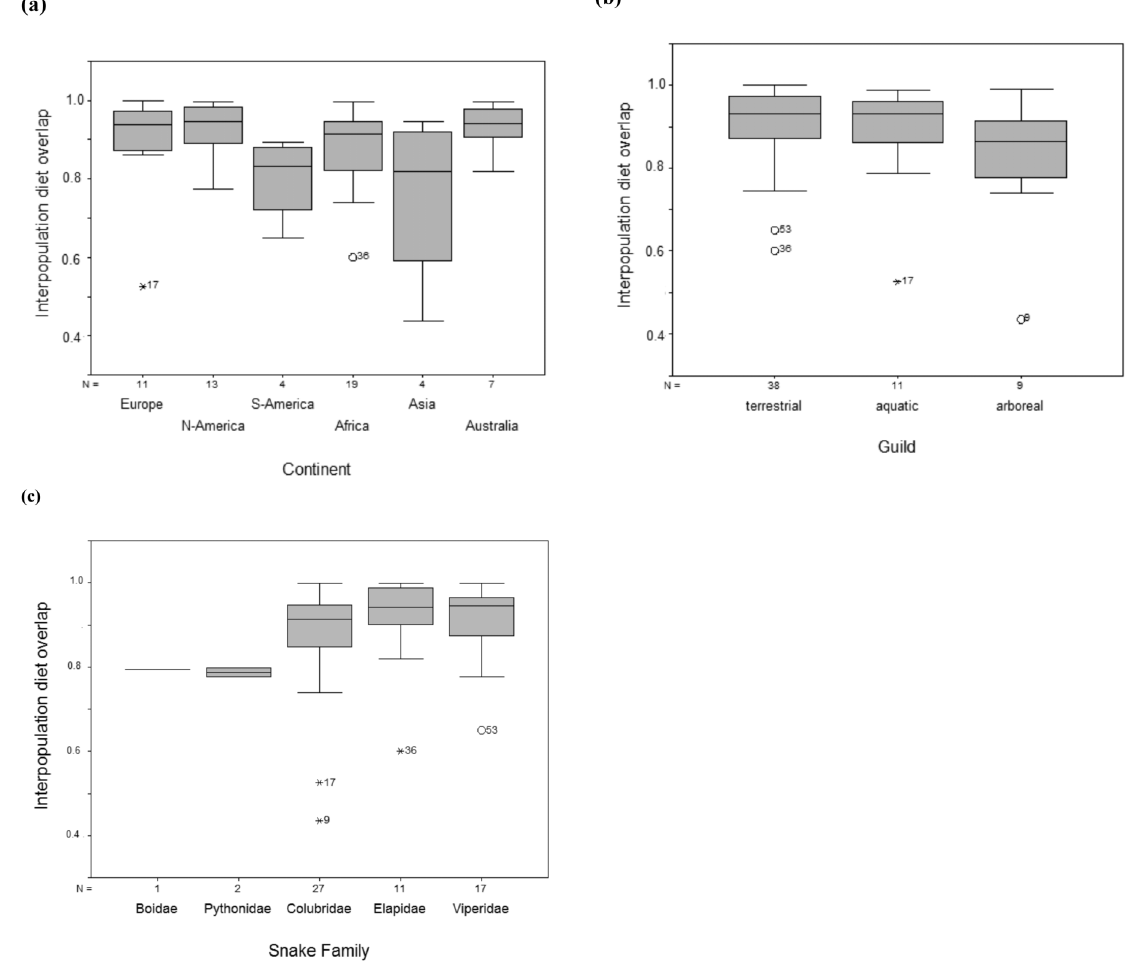
Fig. 2. Means (and dispersion measures) of the interpopulation diet overlap values (general affinity criterion) among continents (a), guilds (b), and snake families (c). Outliers in graphics: 9 = Elaphe quadrivirgata, 17 = Natrix maura , 36 = Notechis scutatus , 53 = Sistrurus catenatus . N = number of